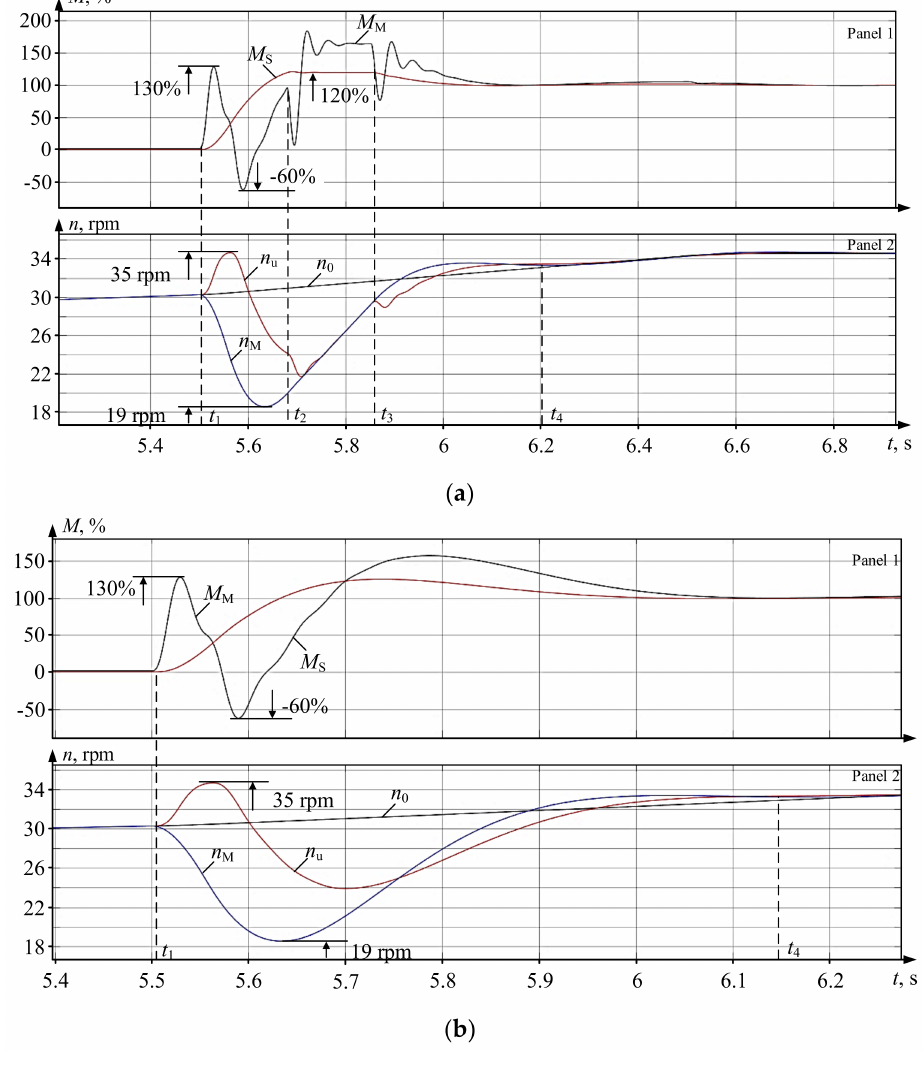
Figure 11. Torque and speed transients in case of shock (impact) load, elastic torque limited ( a ) and not limited ( b